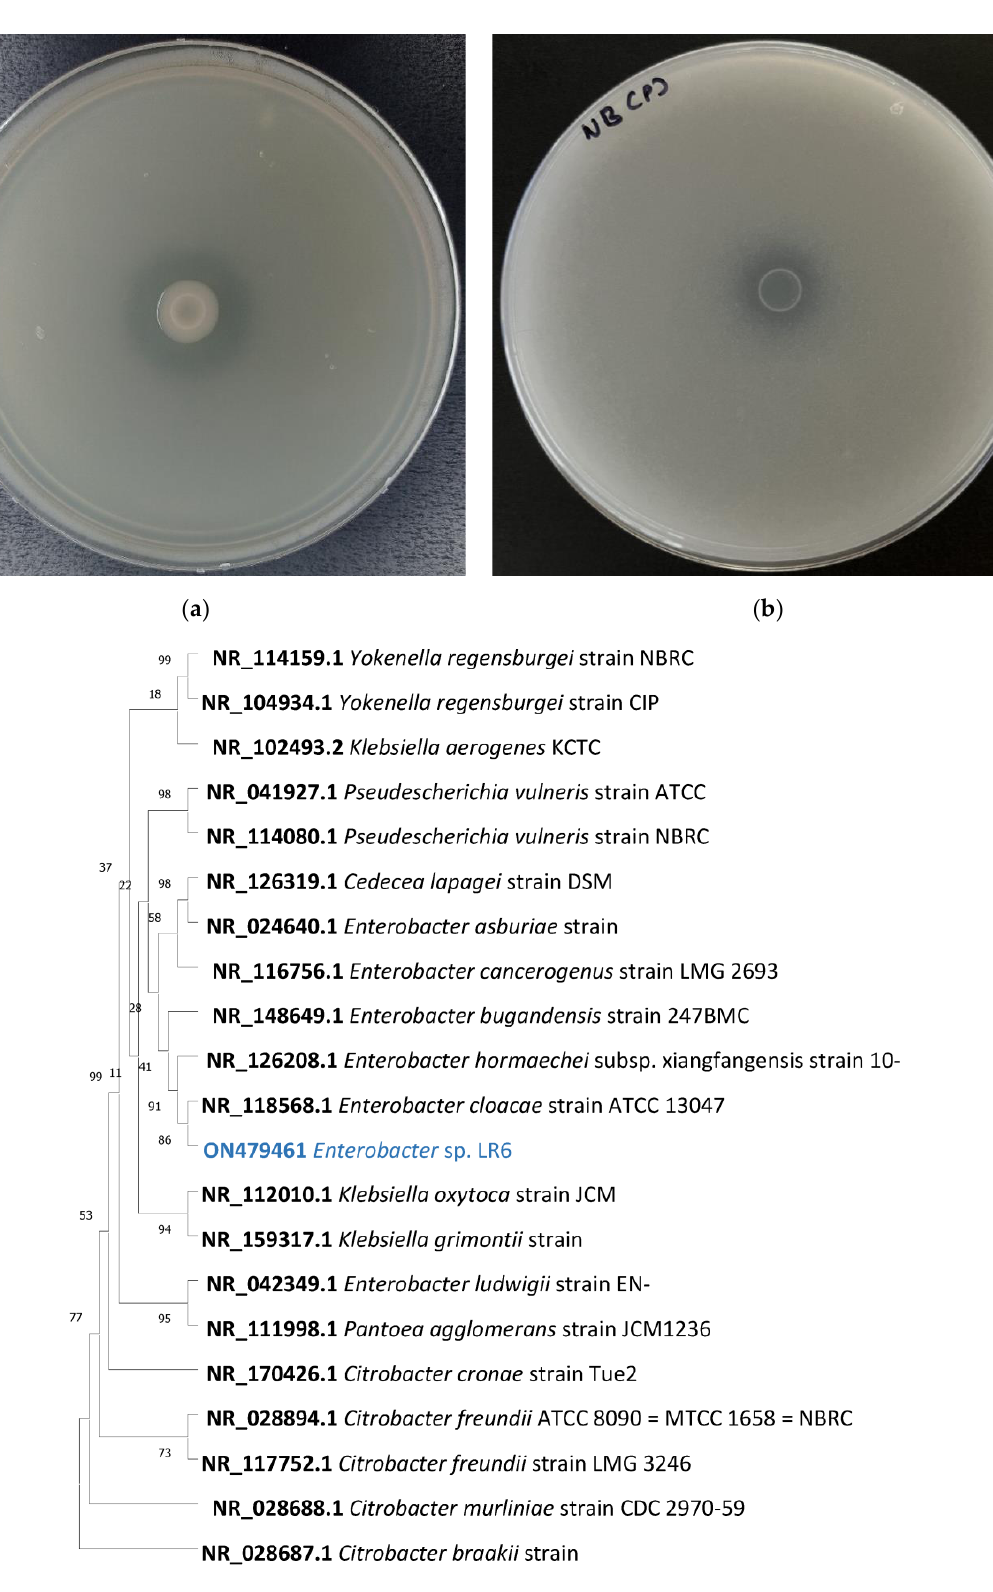
Figure 1. Enterobacter sp. LR6 showing silicate solubilization on Bunt and Rovira silicate medium ( a ), phosphate solubilization on NBRIP medium ( b ), 16s rRNA gene-sequence-based phylogenetic tree constructed using the maximum likelihood method. Based on the 16s rRNA search, the closely